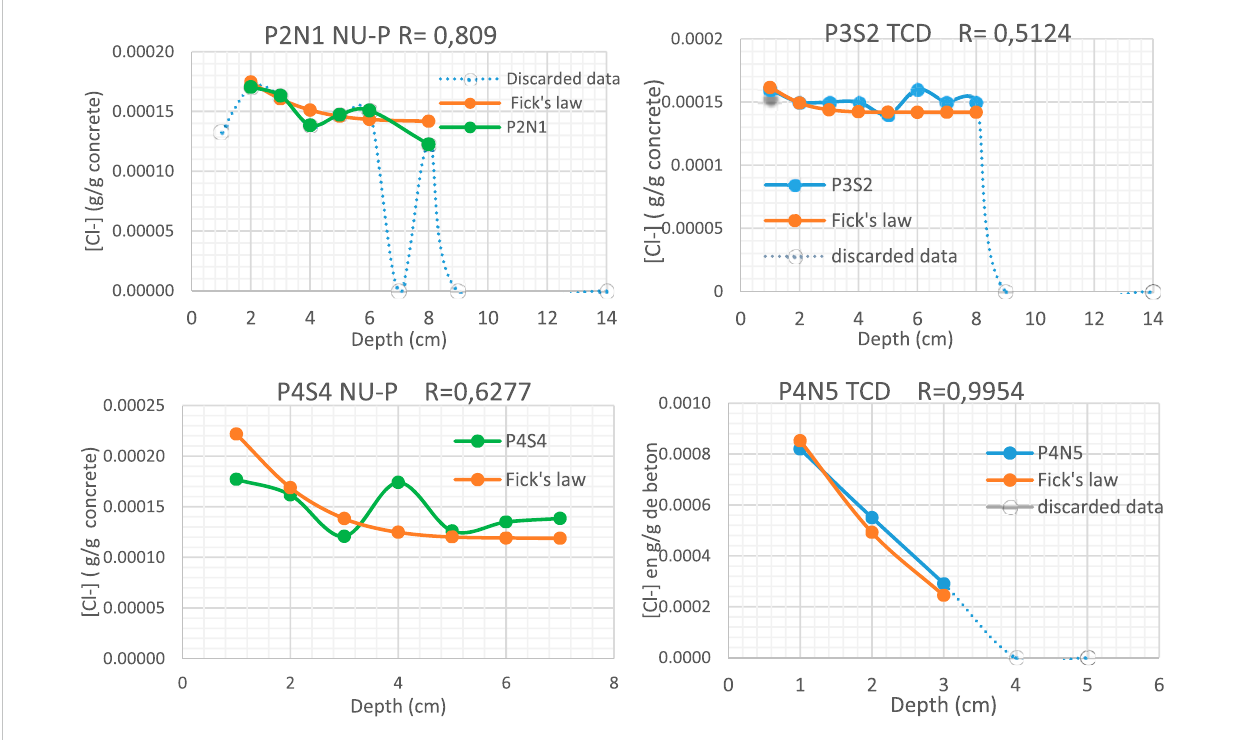
FIGURE 4 Examples of pro fi les obtained in three beams (P2, P3, and P4), on north and south faces (N/S) for two operators (TCD and NU) with a few outliers excluded from the analysis (discarded data) and discarded pro fi